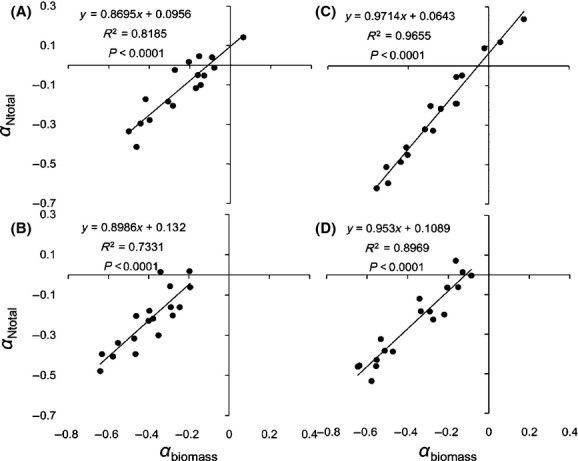
Relationship between αNtotal and αbiomass for Stipa under reduced precipitation. S. baicalensis (A), S. bungeana (B), S. grandis (C), and S. breviflora (D).